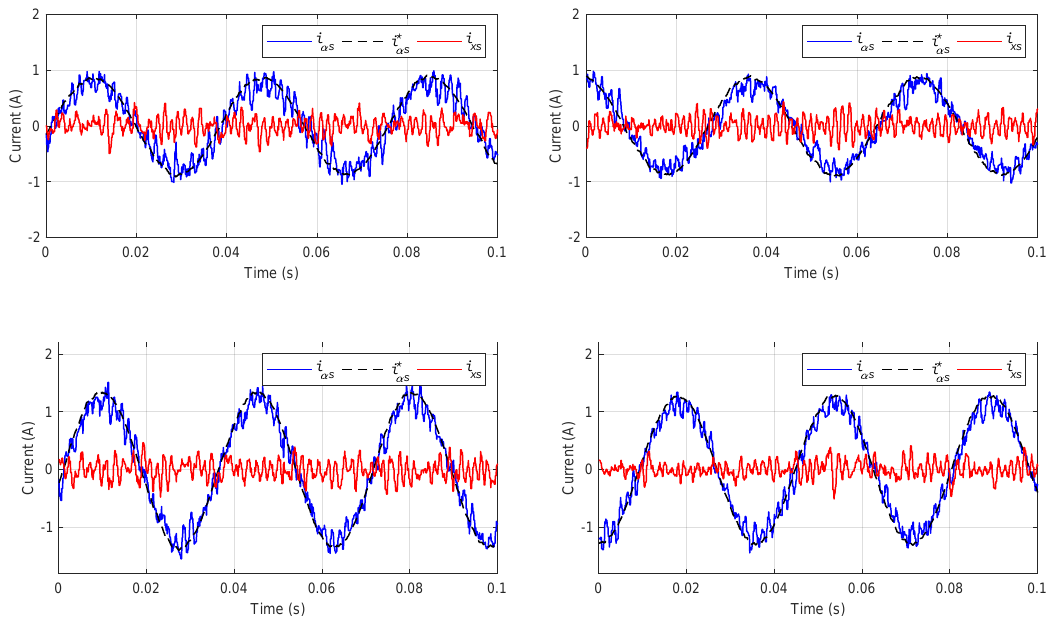
Figure 6. Experimental comparison of the proposed controller ( right ) against a traditional PCC using fixed weighting factors ( left ) at two operating regimes ( top and bottom